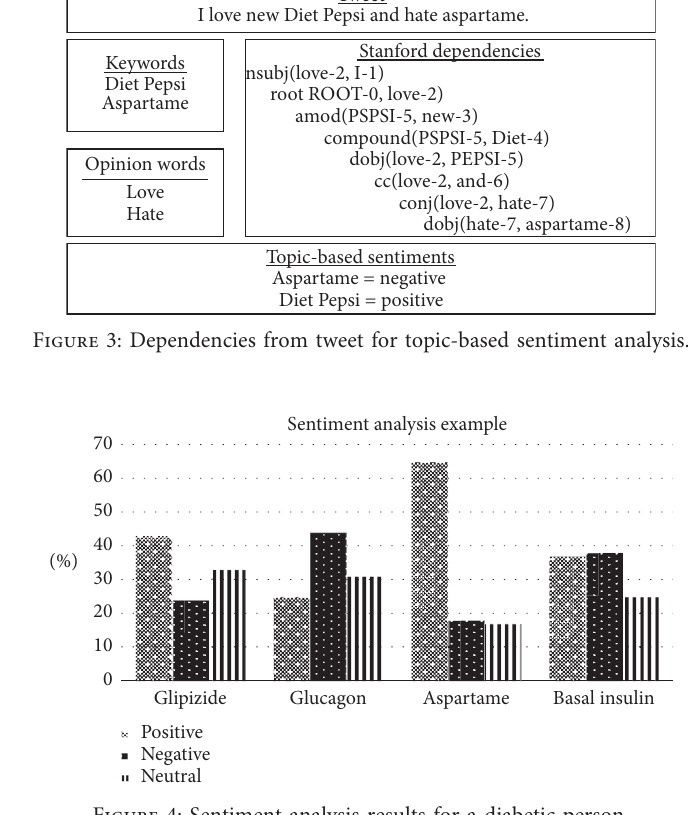
Figure 4: Sentiment analysis results for a diabetic person.